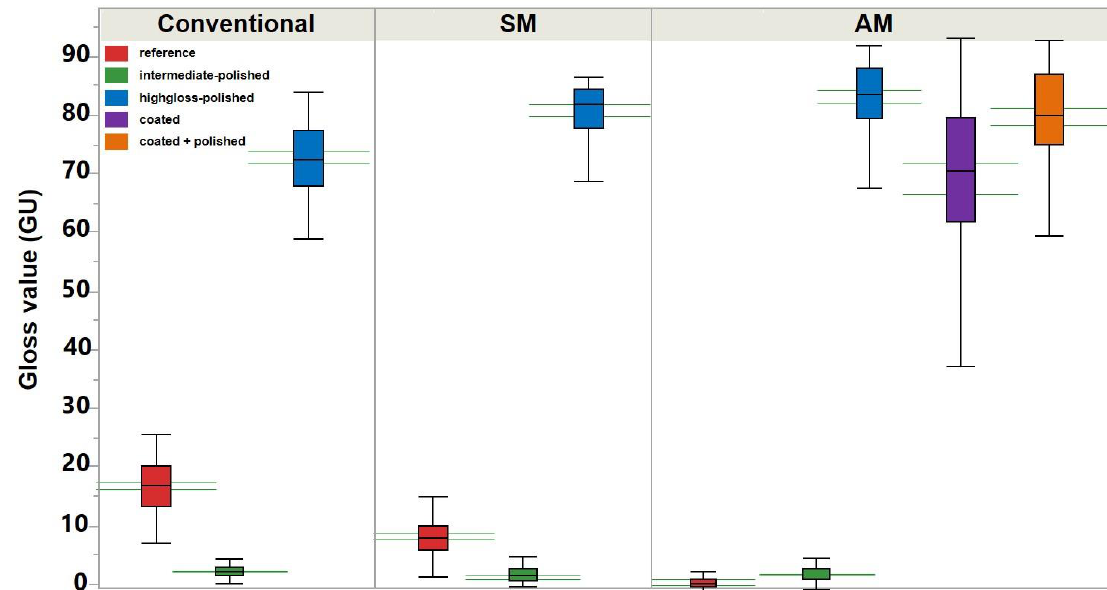
Figure 7. Gloss value of auto-polymerizing (conventional), milled (SM), and 3D printed (AM) denture base materials. The green horizontal lines represent the confidential intervals for each dataset.